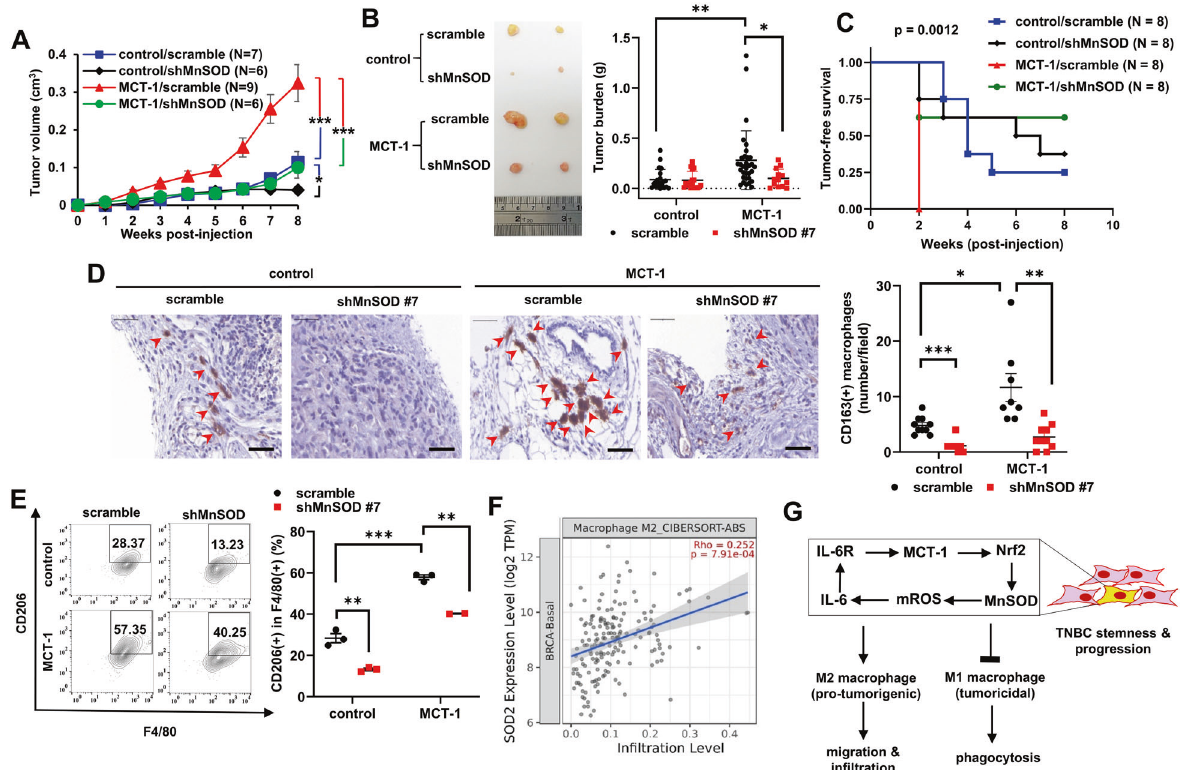
Fig. 6 Targeting MnSOD suppresses TNBC progression and M2 macrophage in fi ltration. A MDA-MB-231 cells (1 × 10 6 ) with or without MCT-1 overexpression (control vs. MCT-1) and MnSOD knockdown (scramble vs. shMnSOD) were orthotopically implanted into the